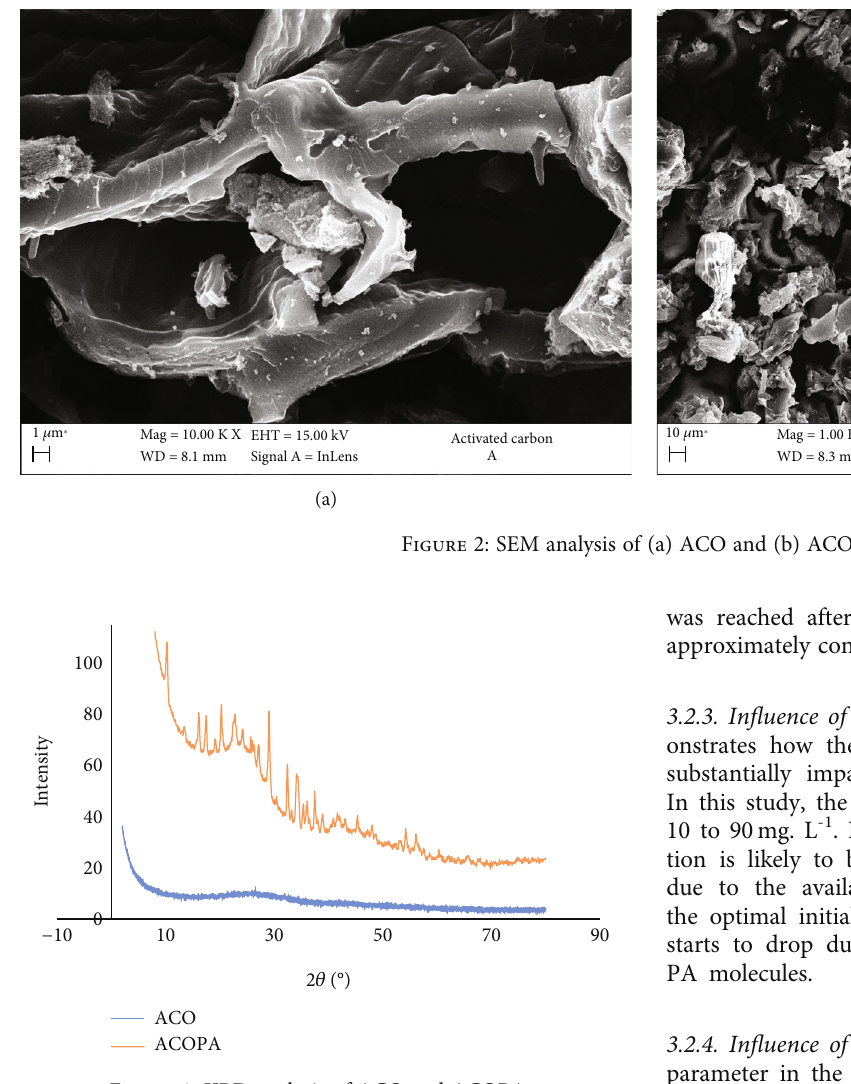
Figure 3: XRD analysis of ACO and